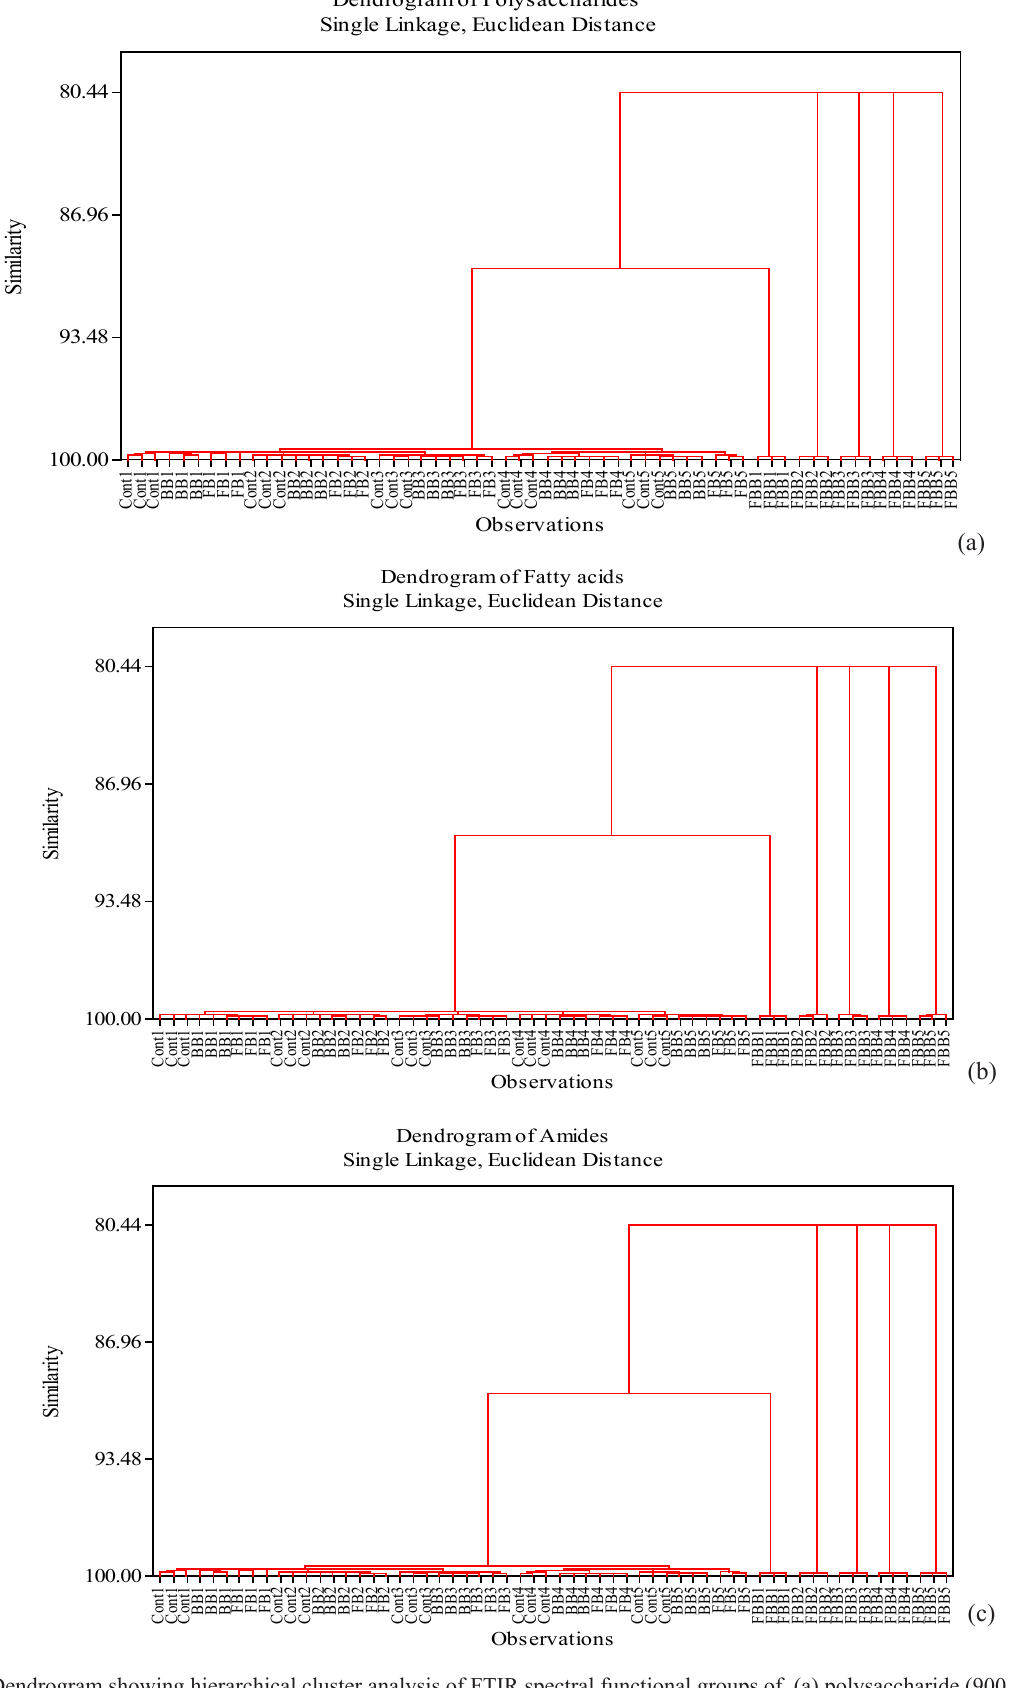
Figure 2 : Dendrogram showing hierarchical cluster analysis of FTIR spectral functional groups of, (a) polysaccharide (900 - 1200 cm-1), (b) fatty acid (2800 - 3000 cm-1 and 1400 - 1500 cm -1 ) and (c) amide (1500 - 1800 cm-1) exudates of bacterial (BB), fungal (FB) and fungal - bacterial (FBB) biofilms at five (0.25, 0.5, 1.5, 3 and 6 days) harvests. Number followed by each treatment and control represent the harvesting times (1 = 0.25, 2 = 0.5, 3 = 1.5, 4 = 3 and 5 = 6